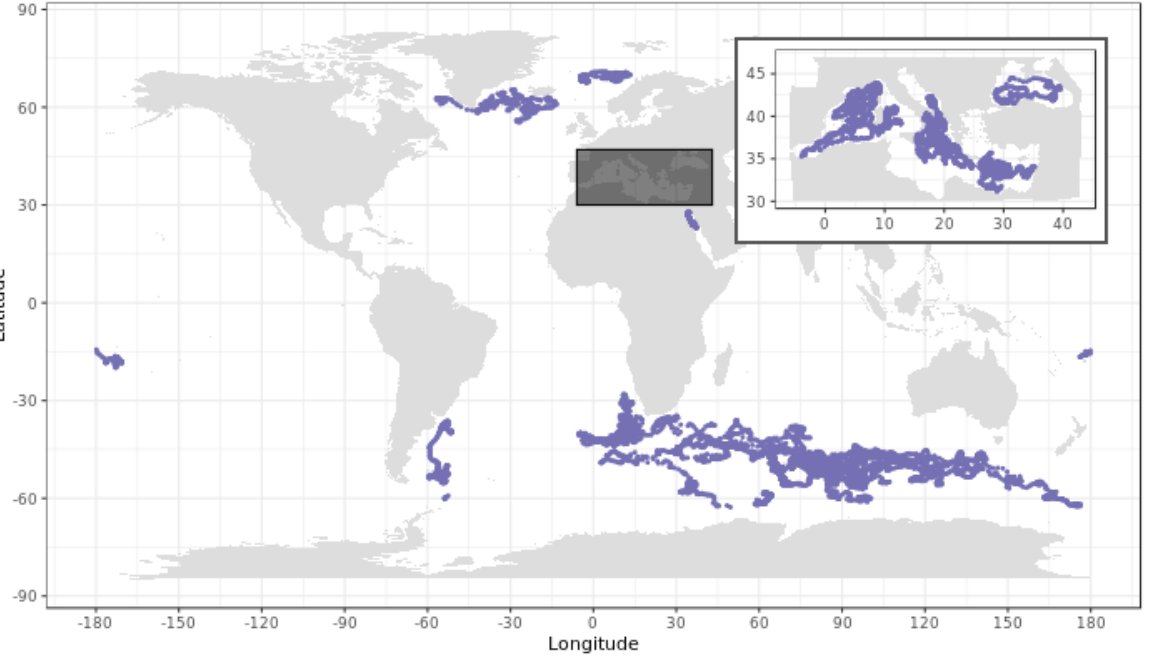
Figure 1. Sampled stations by the 55 profiling BGC-Argo floats considered in this study. Floats were programmed to drift at a parking depth of 1000 dbar and acquire